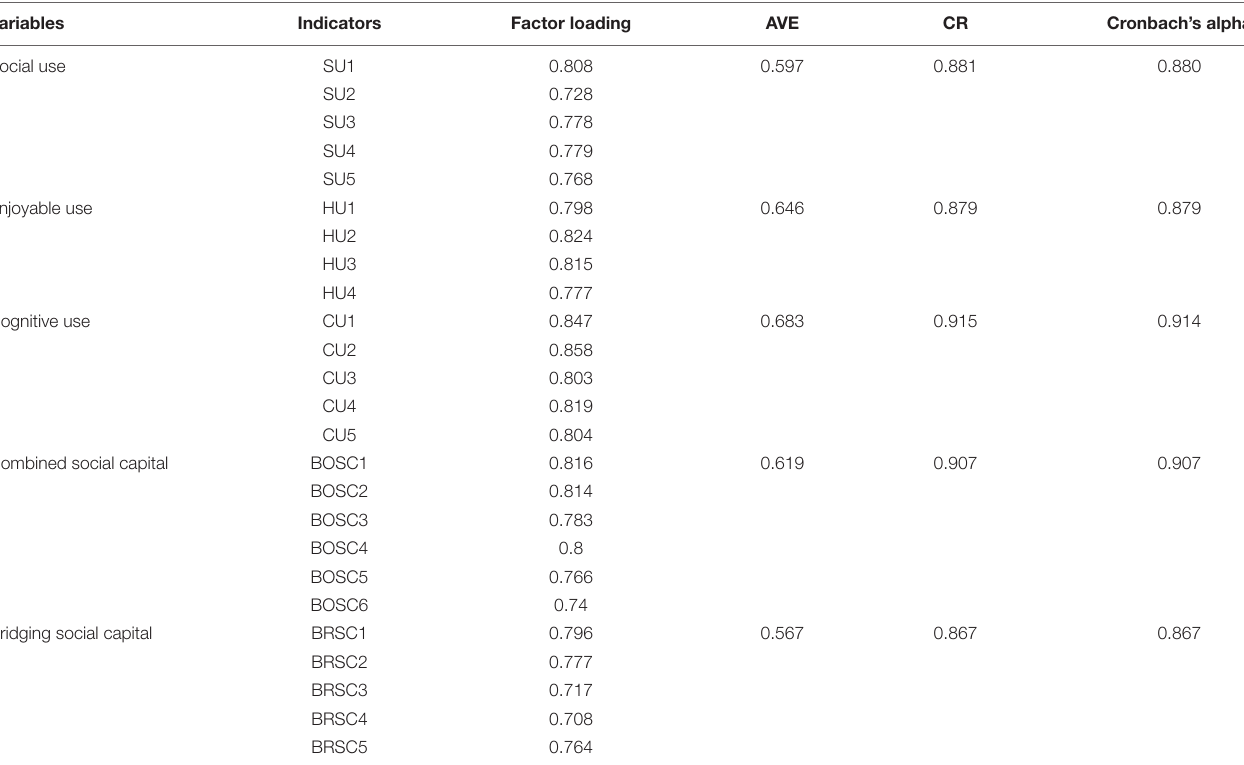
TABLE 1 | Reliability and validity